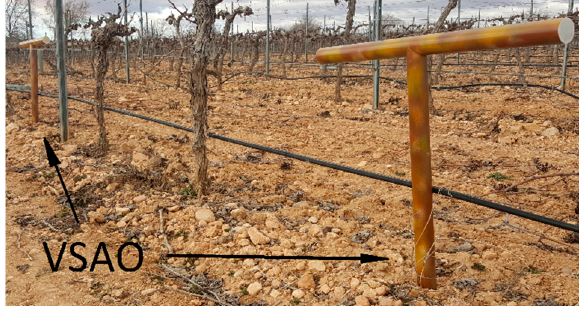
Figure 2. Vine-shaped artificial objects (VSAOs) in the test area of the scan.